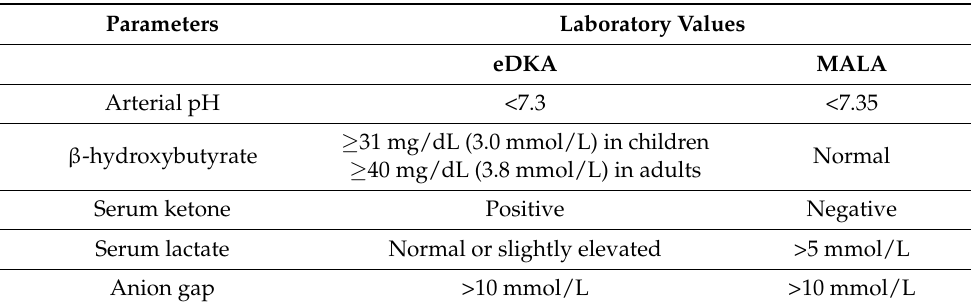
Table 1. Diagnostic criteria of euglycemic diabetic ketoacidosis and metformin-associated lactic acidosis [19,27].